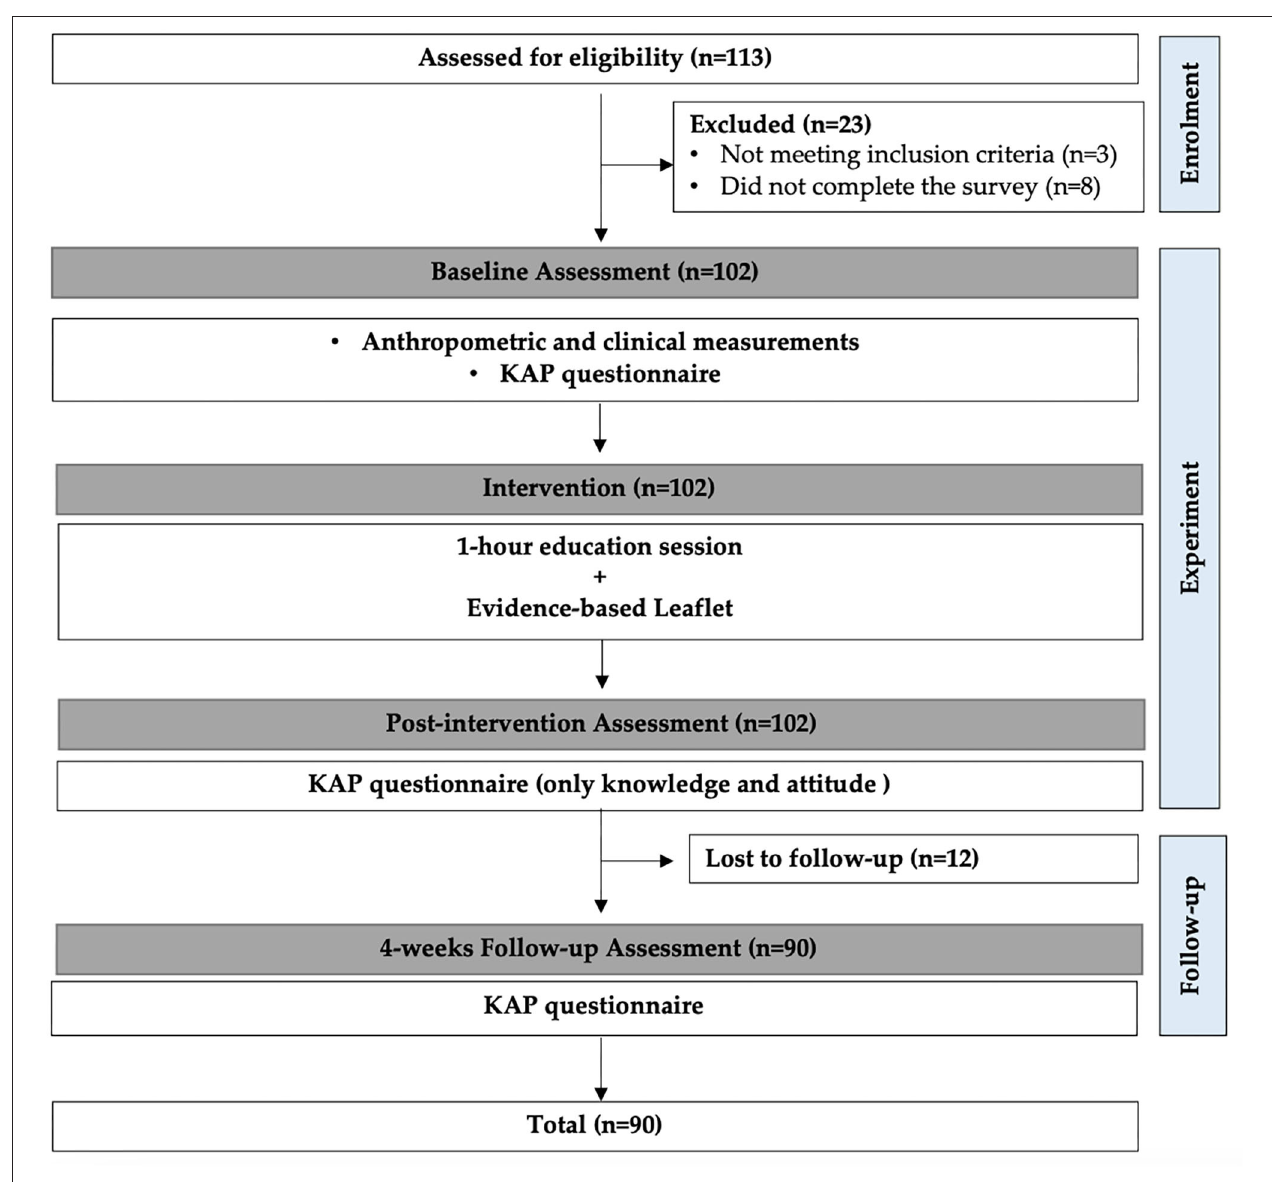
FIGURE 1 | Flow of participants and study